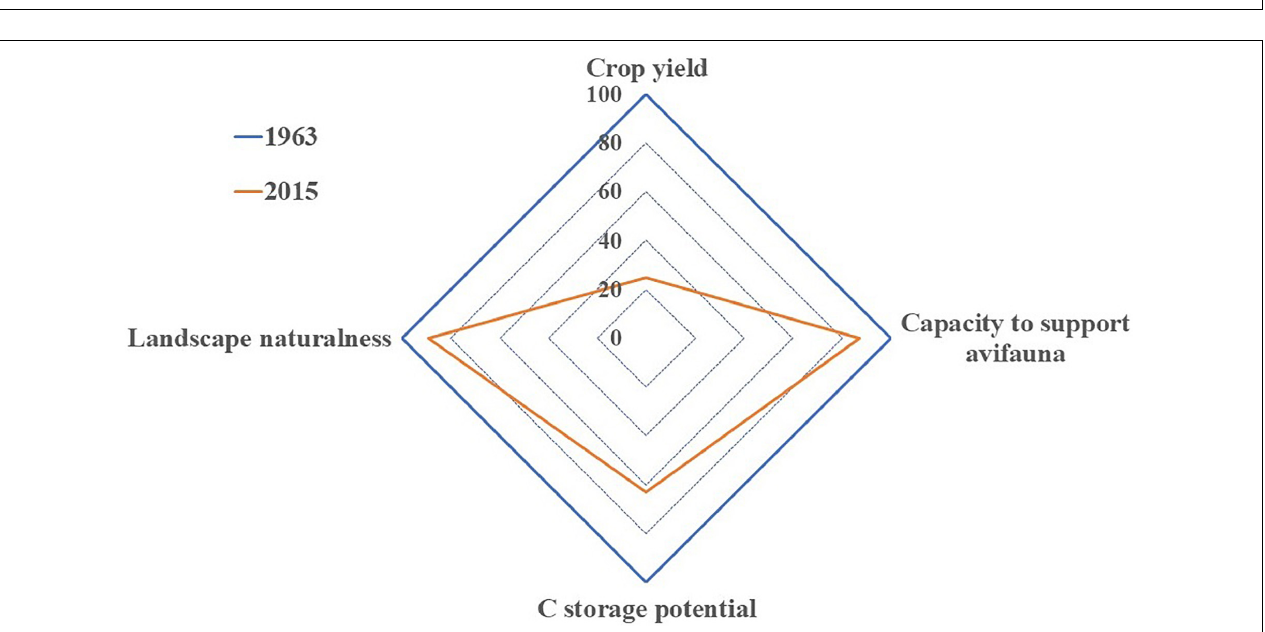
FIGURE 7 | Percentage of change in ecosystem services provision capacity indices in the study area.